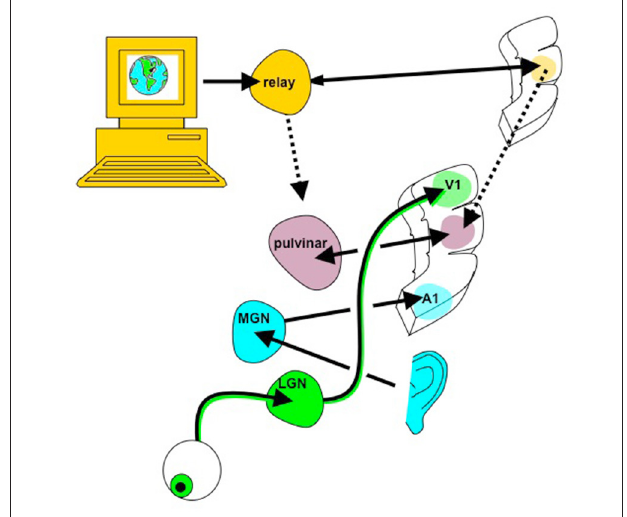
FIGURE 4 | Whole brain emulation to mediate digital information exchange. Instead of using the existing sensorimotor apparatus for internet browsing (eyes to see the screen, hands to control mouse/keyboard), in principle digital information, including abstract data structures that have no obvious sensory correlate, could be navigated via a customized “internet organ” (akin to the retina or organ of Corti) leveraging the numerous pattern recognition computational abilities of neocortex. The emulated {thalamocortical’} circuit processing this digital data could be reciprocally linked with real thalamic and cortical areas known to already process multi-modality sensory information, such as the pulvinar, angular gyrus, and tempoparietal junction. Figure reprinted from Serruya and Kahana (2008) with permission from